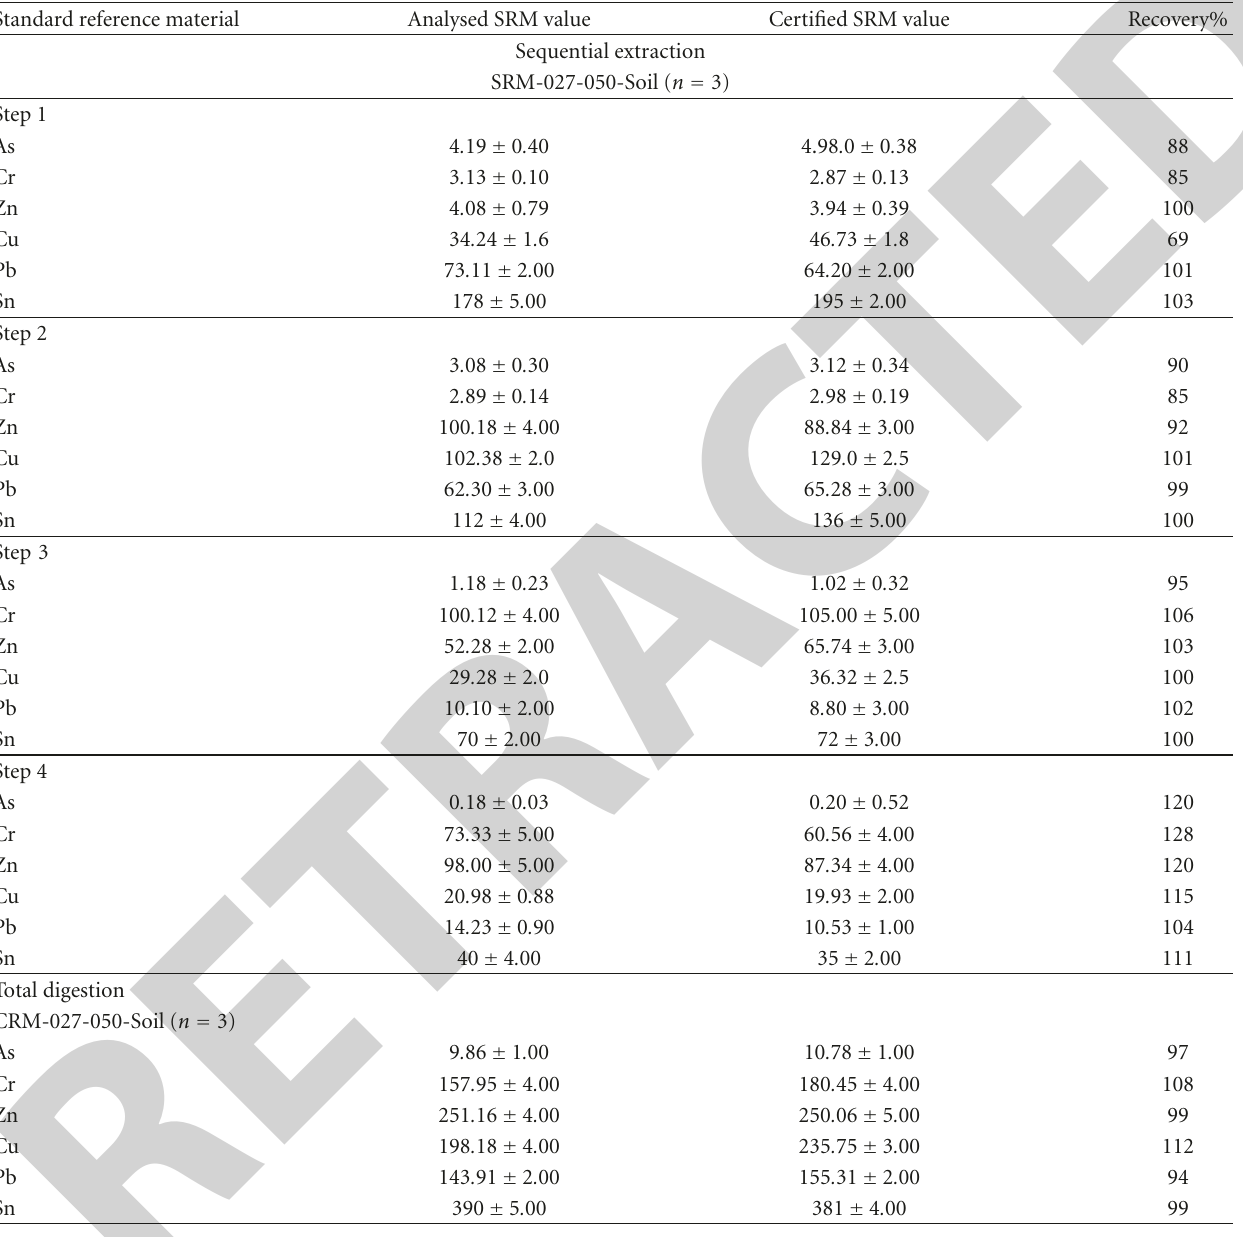
Table 5: Results of analysis of standard reference materials (SRM) in comparison with certified values.